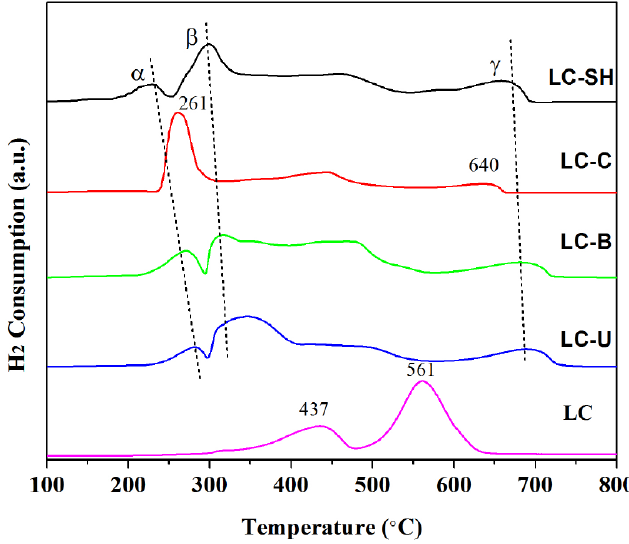
Figure 11. Hydrogen temperature-programmed reductions (H 2 -TPR) figures of catalysts with different nitrogen sources.